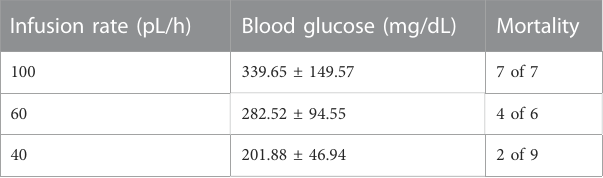
TABLE1Bloodglucoseandmortalityrateinresponsetoi.v.glucoseinfusionin 4 h MCAO mice. Infusion rate